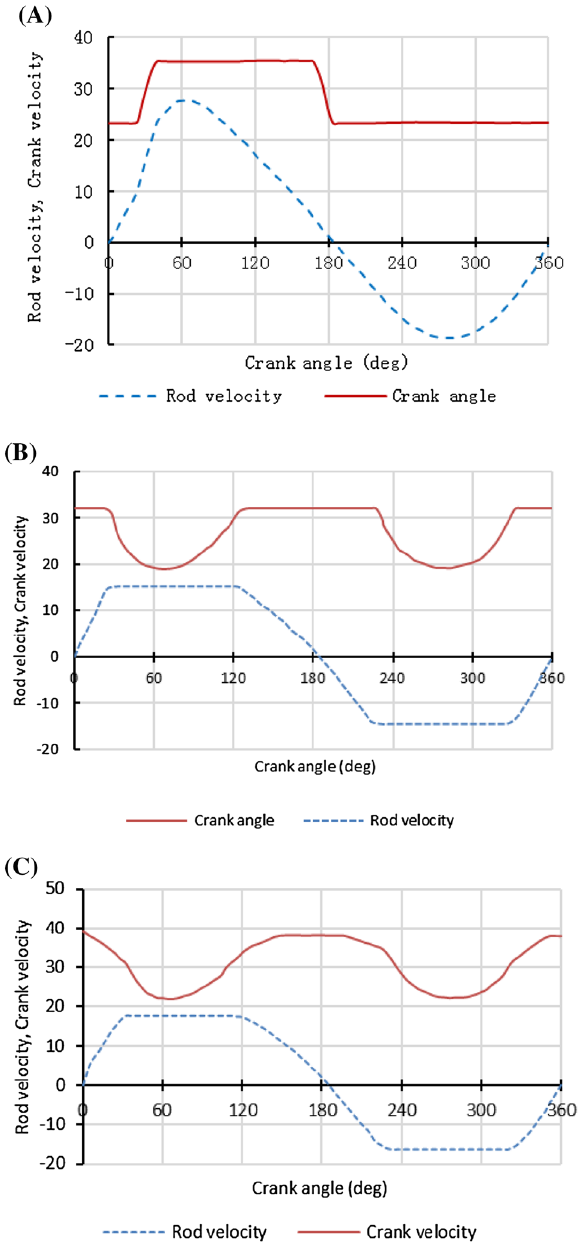
Fig. 16 Variable speed profile for motor (Watson et al. 2005). a Case one, b case two, c case three